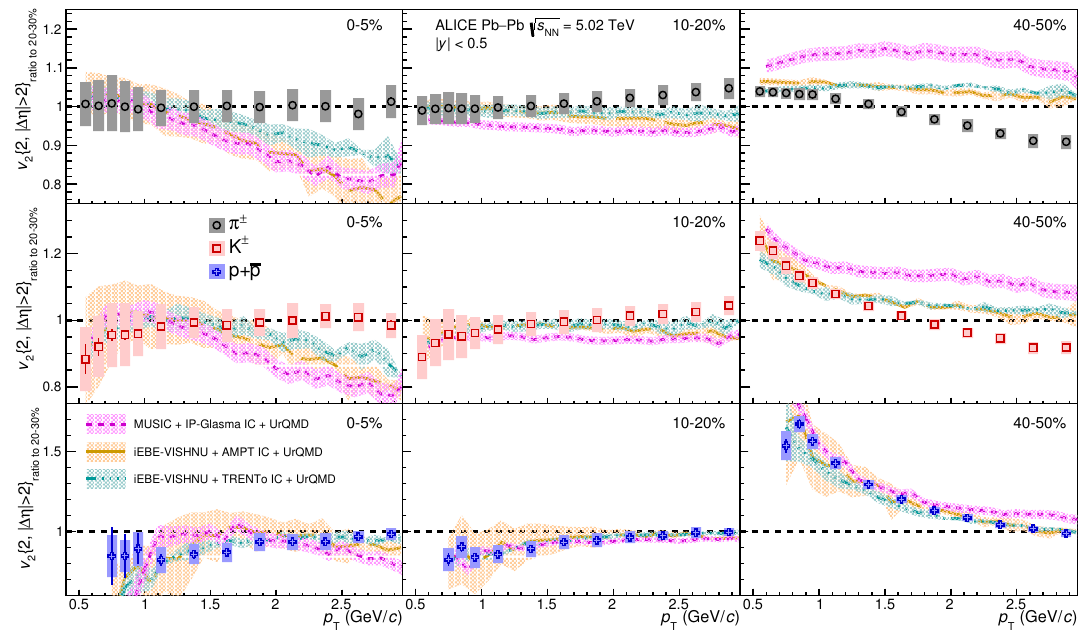
Figure 17 . (Colour online) Centrality dependence of v 2 ( p T ) for (cid:25) (cid:6) (upper pan- ratio to 20 (cid:0) 30% els), K (cid:6) (middle panels), and p+p (lower panels) compared to hydrodynamical calculations from the MUSIC model using IP-Glasma initial conditions (magenta) [82], the iEBE-VISHNU hybrid model using AMPT (orange) or TRENTo (cyan) initial conditions [83]. Statistical and systematic uncertainties of the data points are shown as bars and boxes, respectively.